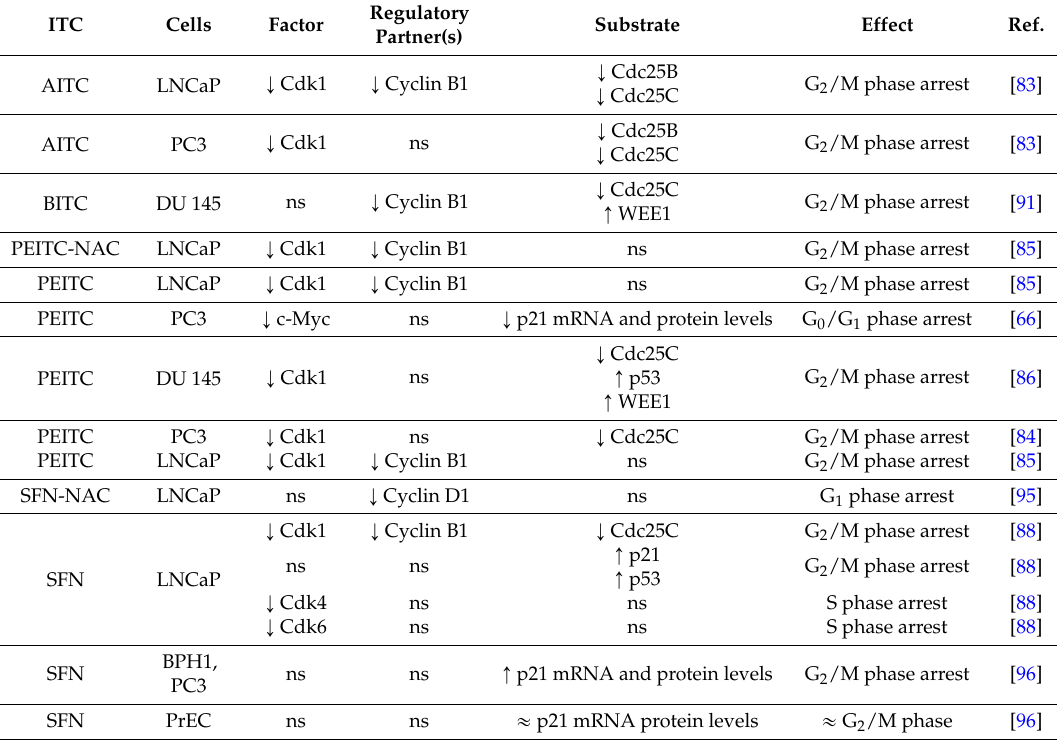
Table 2. Cell cycle arrest induced by ITCs in vitro .